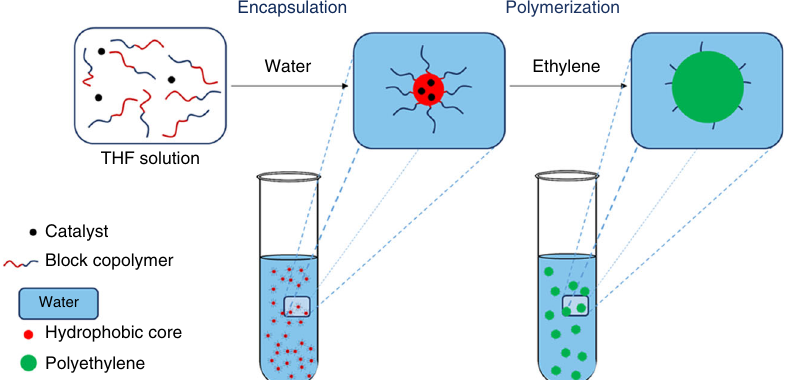
Fig. 1 Catalyst encapsulation approach for ethylene polymerization in water. Our technical approach consists of fi rst, encapsulating an ole fi n polymerization catalyst in micelles formed by an amphiphilic block copolymer and second, performing the polymerization of ethylene within these micelles to yield a stable PE latex